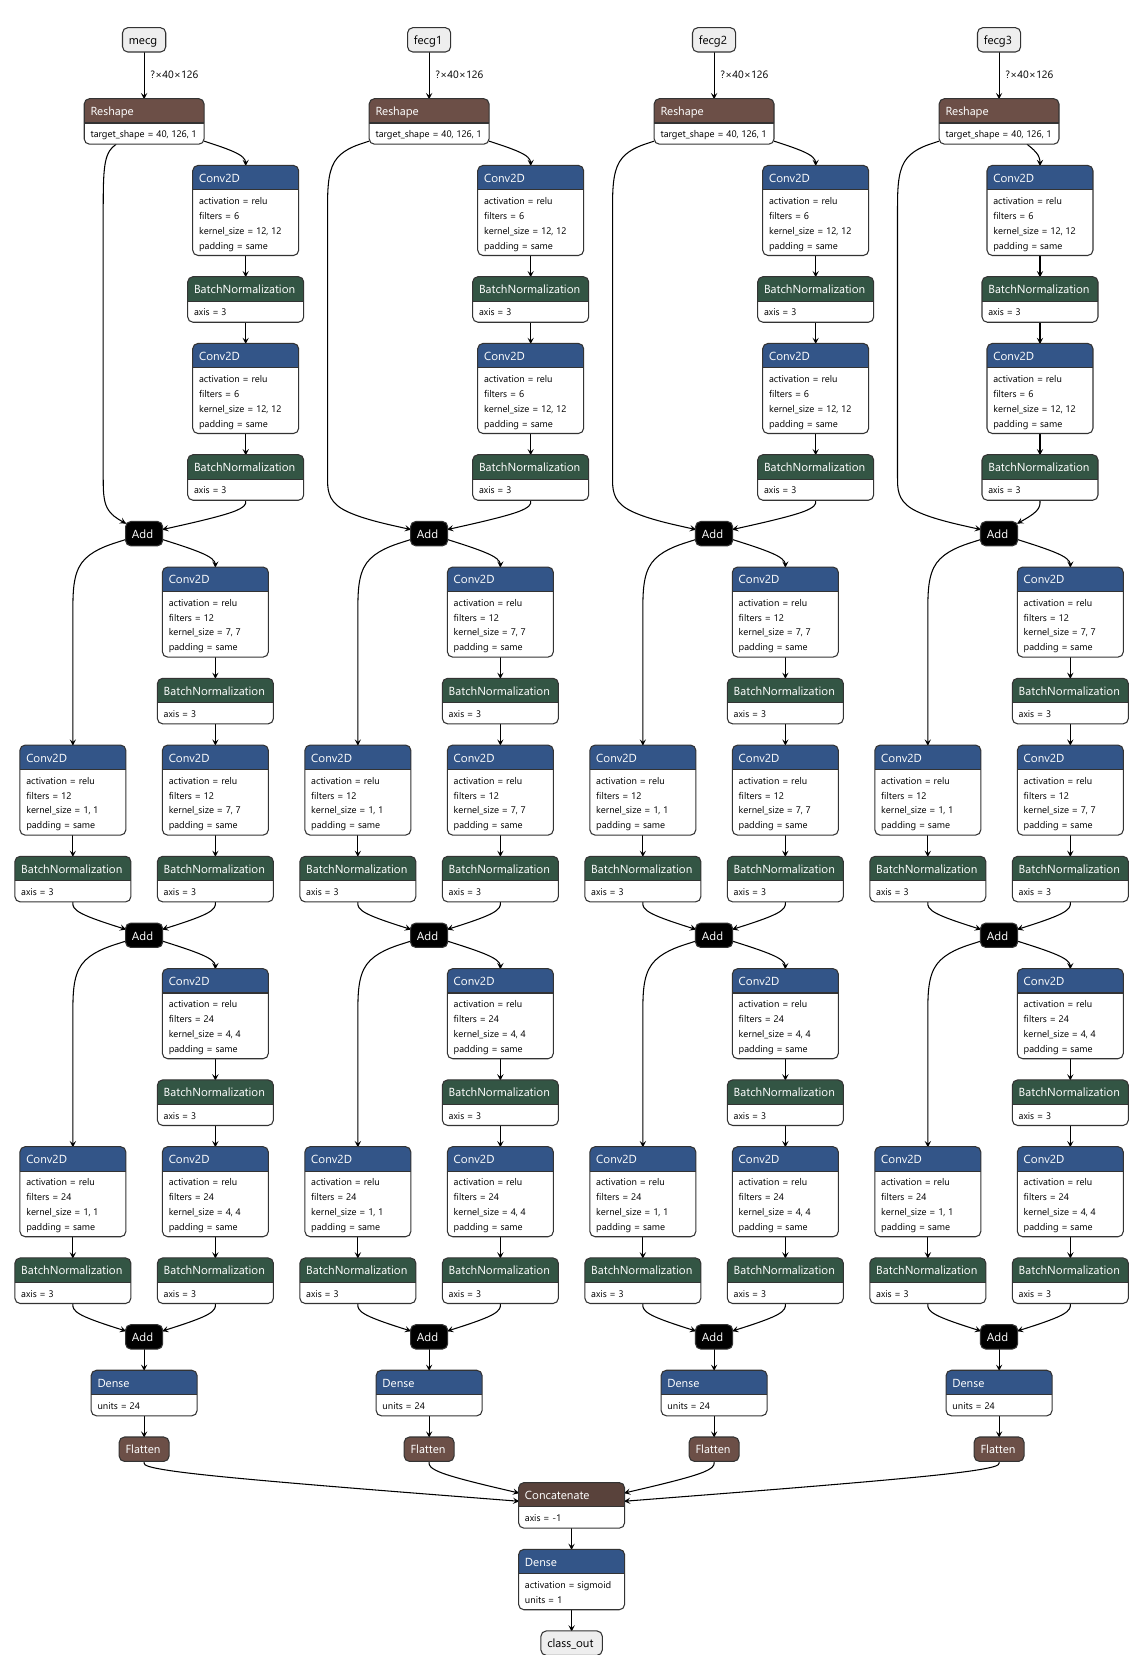
Figure A3. The full neural network